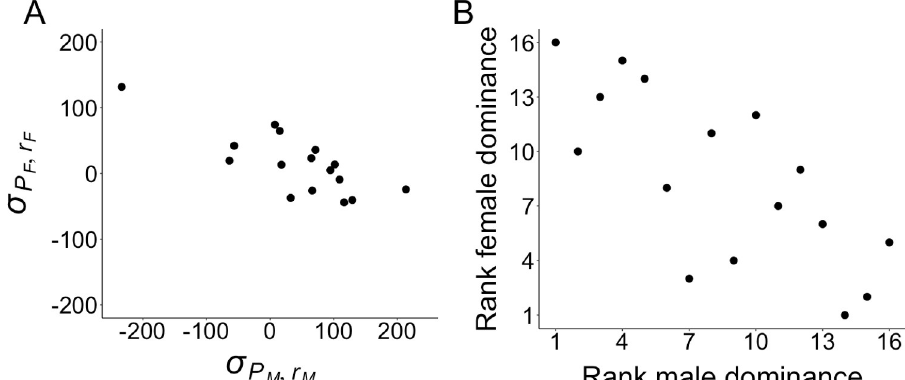
Fig 3. SSDR of the allelic variation underlying fitness. (A) The relative amount of recessive allelic variation for ) and females ( s ) was significantly negatively correlated ( r = − 0.779 [95% CI − 0.92 fitness in males ( s s PM ; rM ; s PF ; rF P M ; r M P F ; r F to − 0.46], P = 0.0004) across strains ( N = 16; units reflect nonstandardized residual fitness from a model that accounted for environmental and epistatic variance), and (B) the same relationship illustrated and analyzed as ranks (i.e., strains ranked in order of their relative “dominance” over one another; r : − 0.738, P = 0.0016). Strains s PM ; rM ; s PF ; rF tended to be enriched with allelic variation for fitness that was dominant in their heterozygous sons but recessive in their heterozygous daughters and vice versa. SSDR, sex-specific dominance